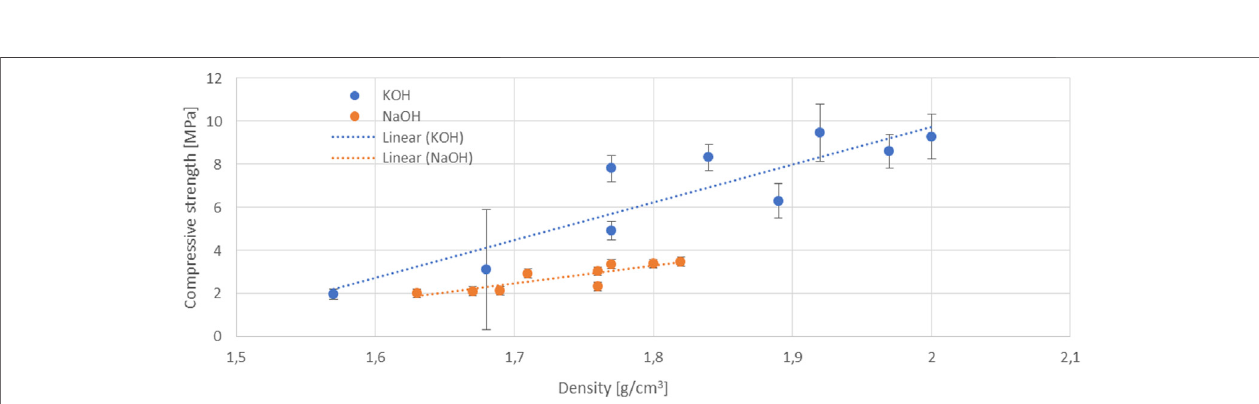
FIGURE 6 | Compressive strength of the hardened samples (from KOH- and NaOH-based AAAs) as a function of their density.